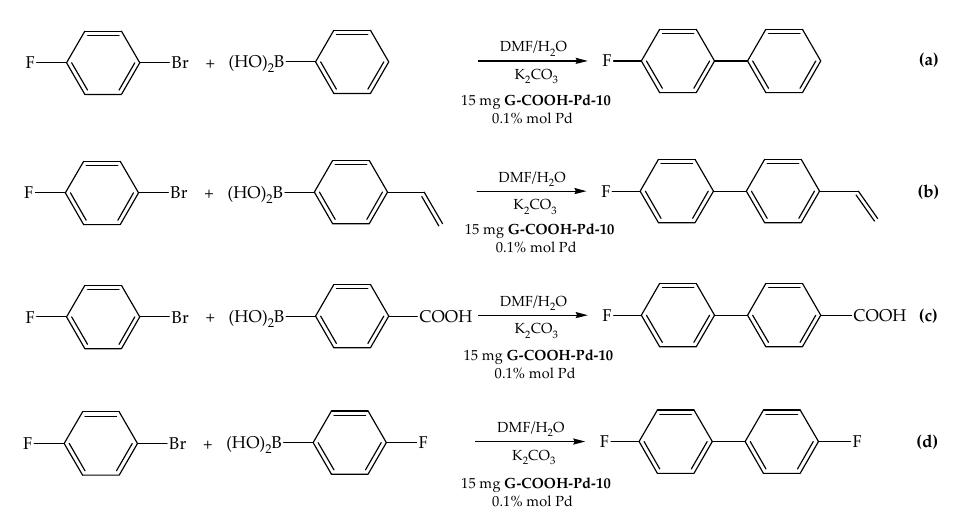
Scheme 1. Reaction of 1 ‐ bromo ‐ 4 ‐ fluorobenzene with ( a ) phenylboronic acid; ( b ) 4 ‐ vinylphenylboronic acid; ( c ) 4 ‐ carboxyphenylboronic acid; and ( d ) 4 ‐ fluorophenylboronic acid